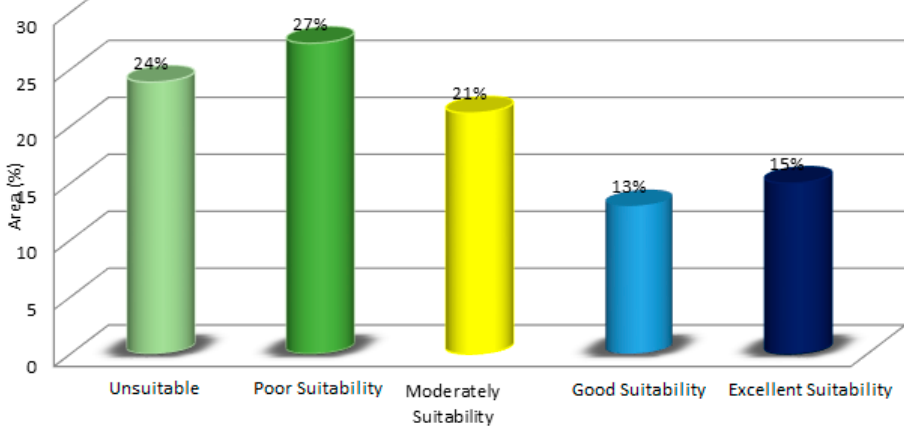
Figure 6. Percentage of area covered by the different rainwater harvesting suitability.